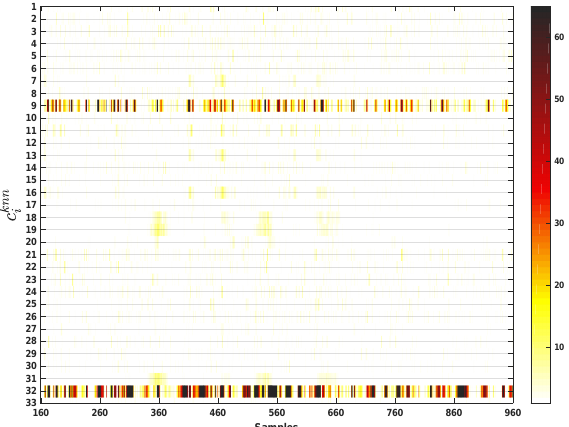
Figure 16. The variable contribution by kNN for fault 11 of